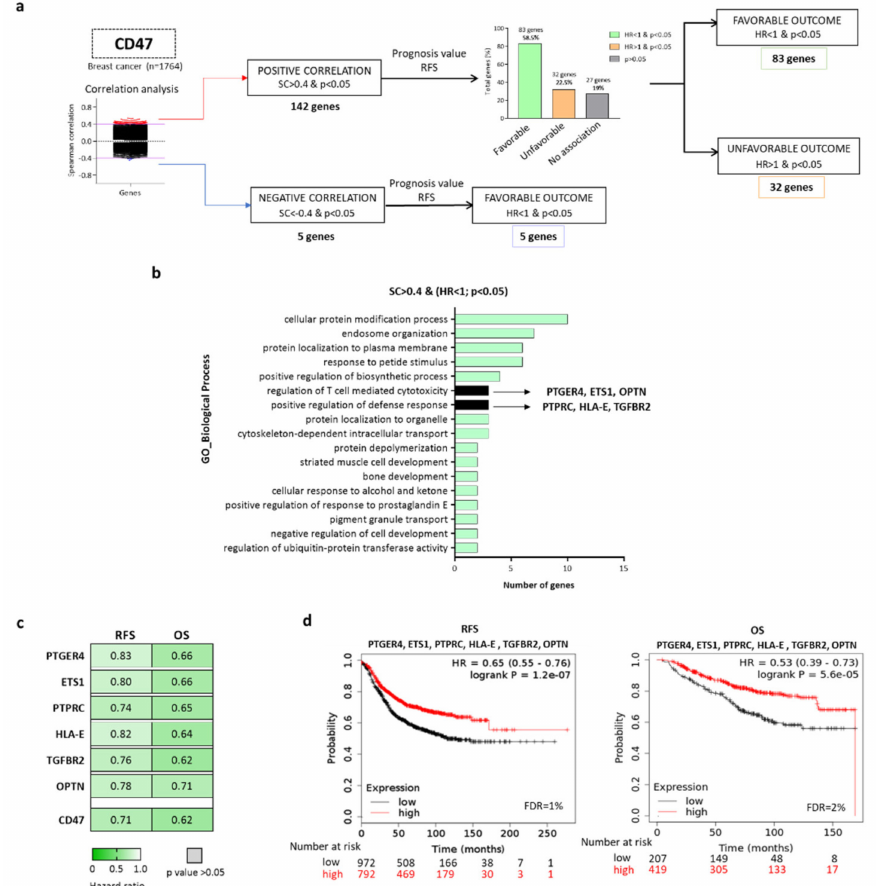
Figure 1. Immune system related transcriptional profiles associated with outcome and with CD47 expression in breast cancer. ( a ) Flow chart of gene selection, describing the tools and selection criteria used. ( b ) Functional analyses of the selected genes described in A using Enrichr Online Tool. For positively correlated genes (Spearman correlation (SC) > 0.4 and Hazard Ratio (HR) < 1), gene ontologies (GO) of biological process with a p < 0.05 are shown. The processes related to the immune system are highlighted. ( c ) Heat map displaying HR values extracted from Kaplan–Meier survival plots of the association between PTGER4, ETS1, PTPRC, HLA-E, TGFBR2, OPTN, and CD47 individually expressed and patient prognosis, including relapse-free survival (RFS) ( n = 1764) and overall survival (OS) ( n = 626), for all breast subtypes from the exploratory cohort. ( d ) Kaplan–Meier survival plots of the association between PTGER4, ETS1, PTPRC, HLA-E, TGFBR2, and OPTN mean expression levels and patient prognosis, including relapse-free survival (RFS) ( n = 1764) and overall survival (OS) ( n = 626) for all breast subtypes from the exploratory